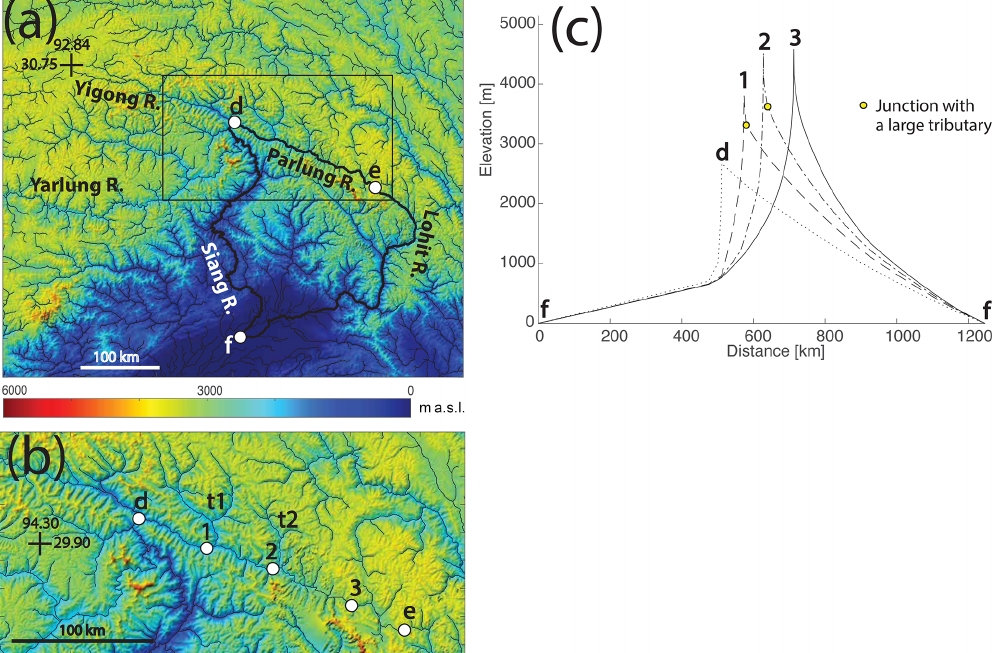
Figure 6. Simulated wind-gap migration along the Parlung valley. (a) Regional map based on the 15arcsec GMTED2010 DEM (approxi- mately 500m resolution; Danielson and Gesch, 2011) showing the Yigong, Parlung, Lohit, Siang, and Yarlung rivers (location is shown as a box in Fig. 2a). The approximate capture location of the Yarlung–Yigong by the Siang is marked by point d. Point e marks the current location of the wind gap between the northwest-flowing Parlung and southeast-flowing Lohit rivers. Point f marks the base level at the con- fluence of the Lohit and Siang rivers. Thin dark lines mark river systems with drainage area larger than 10 8 m 2 , and the bold dark lines mark the river system that is simulated in panel (c) . A box marks the area shown in panel (b) . (b) Map of the Parlung river basin. The Parlung reversed its flow direction following the capture, likely through wind-gap migration from the capture point (point d) to the current location of the wind gap (point e). Points 1, 2, and 3 mark simulated stable wind-gap locations in conjunction with panel (c) . The labels t1 and t2 mark large tributaries of the Parlung river. (c) Profiles of simulated initial and steady-state topography. Curve d – a profile at the time of capture of the Yigong–Parlung by the Siang (the initial topography of the simulations); curve 1 – a profile of a simulated stable wind-gap position developed in a fixed confluence simulation. Note that this stable location is just west of a confluence with a large tributary (t1). Curve 2 – a stable wind-gap position that developed by simulating an avulsion of tributary t1 to the expanding side of the wind gap. This new stable wind-gap position is just west of a confluence with a large tributary t2. Curve 3 – a stable wind-gap position that is attained through an avulsion simulation in which tributaries with drainage area larger than 10 7 m 2 are allowed to avulse. Model parameters are given in Table